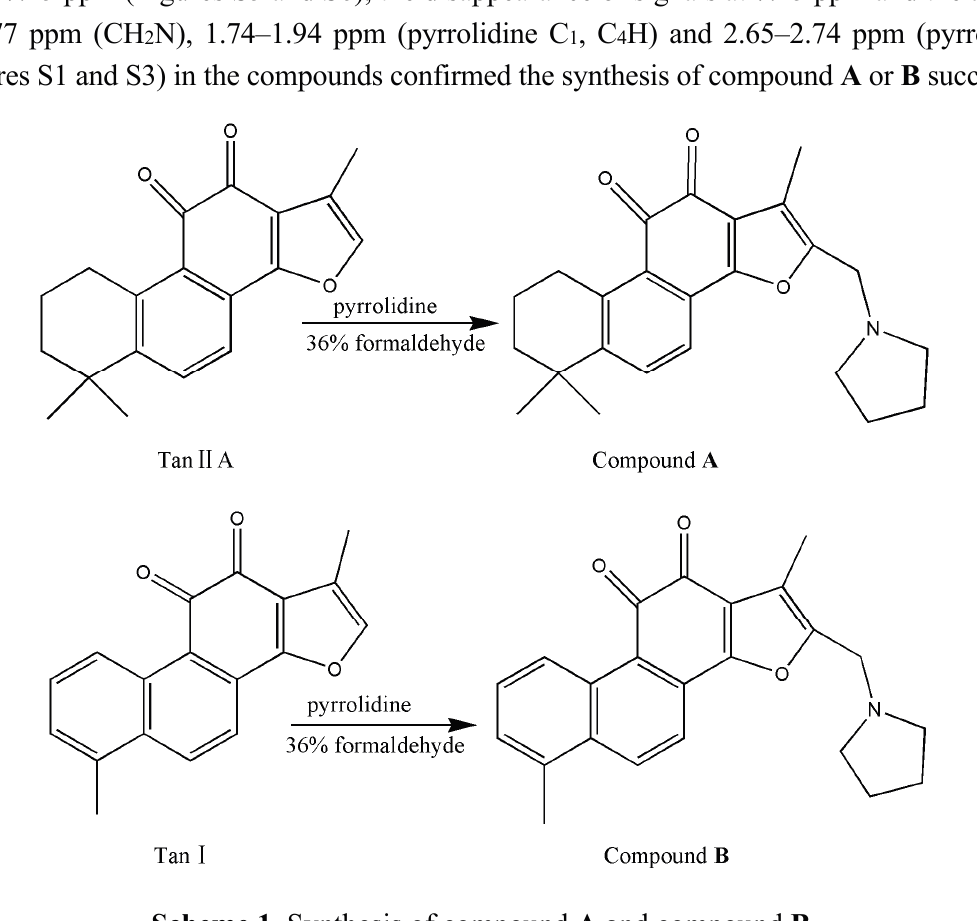
Scheme 1. Synthesis of compound A and compound B